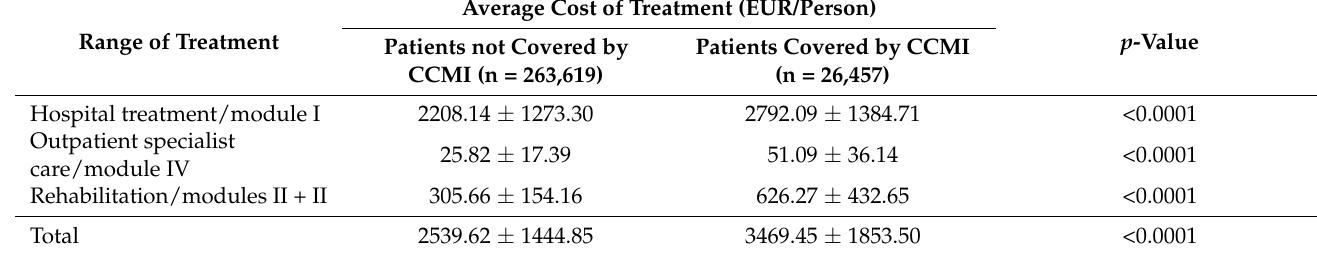
Table 7. Comparison of the average costs of treating patients under CCMI compared to those not included in the programme, from 2017 to 2020. Descriptive data are presented as mean ± standard deviation ( ±